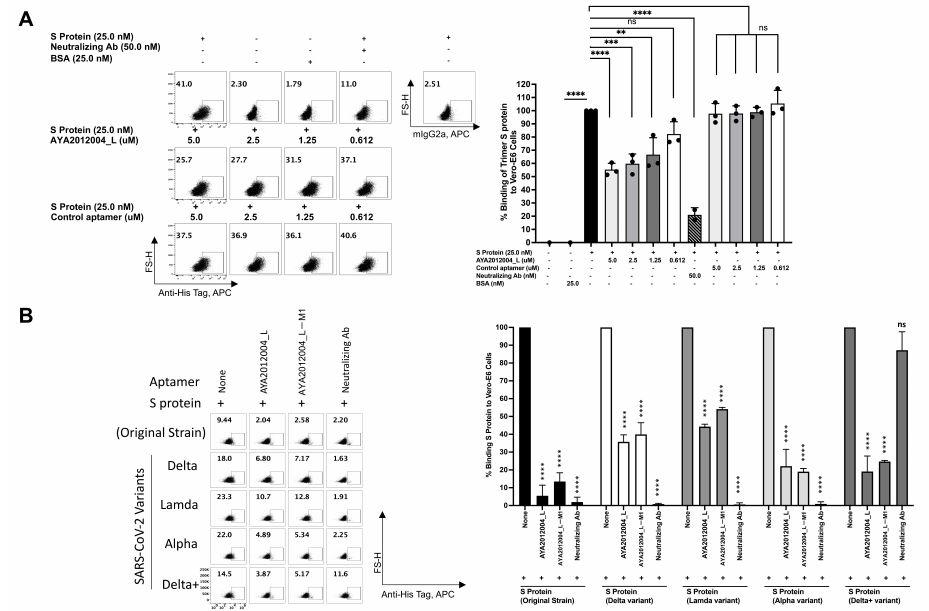
Figure 8. Flow cytometry study on inhibition of SARS-CoV-2 trimer S protein binding to ACE2 receptors on the surface of Vero E6 cells by selected aptamers. ( A ) Concentration-dependent inhibition of SARS-CoV-2 trimer S protein binding to Vero E6 cells by aptamer AYA2012004_L. SARS-CoV-2 trimer S protein was pre-incubated for 1 h in absence or presence of aptamer (AYA2012004_L) at different concentrations, anti-SARS-CoVv2 RBD-neutralizing antibodies or control aptamer with random 40 nucleotides ssDNA in 100 µ L PBS supplemented with 1 mM Mg 2 + as indicated. S